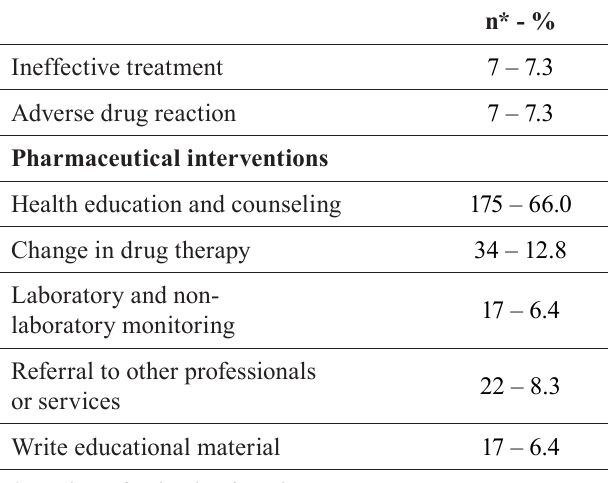
TABLE II - Drug-related problems and pharmaceutical